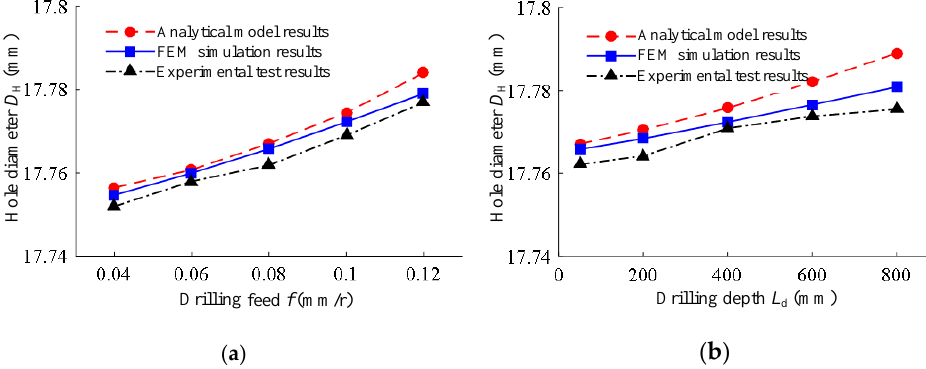
Figure 15. The hole diameters under different drilling conditions: ( a ) under different drilling feeds of drilling speed n = 1200 r/min and drilling depth L d = 50 mm; ( b ) under different drilling depths of drilling speed n = 1200 r/min and feed rate f = 0.08 mm/r.